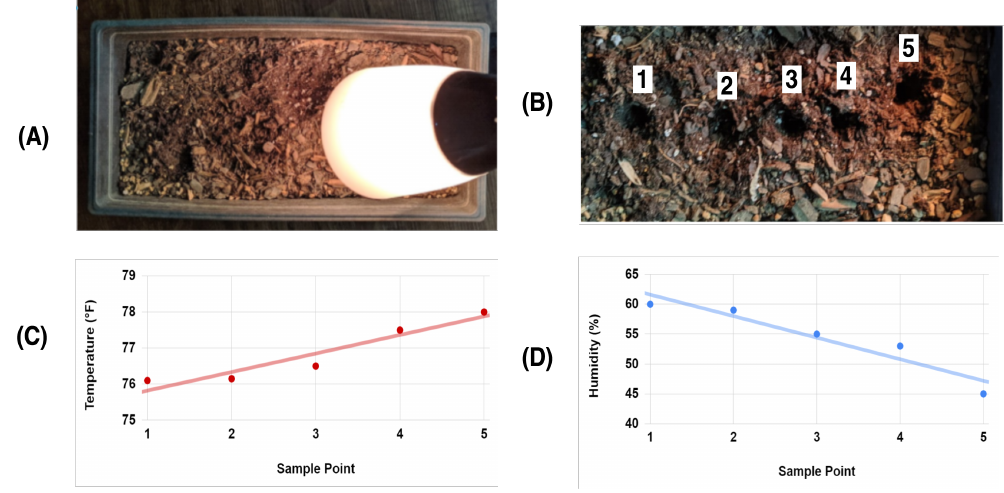
Figure 16. Soil sensing setup. ( A ) Soil conditioning with a lamp; ( B ) Soil measurement locations; ( C ) Temperature measurement profile; ( D ) Moisture measurement